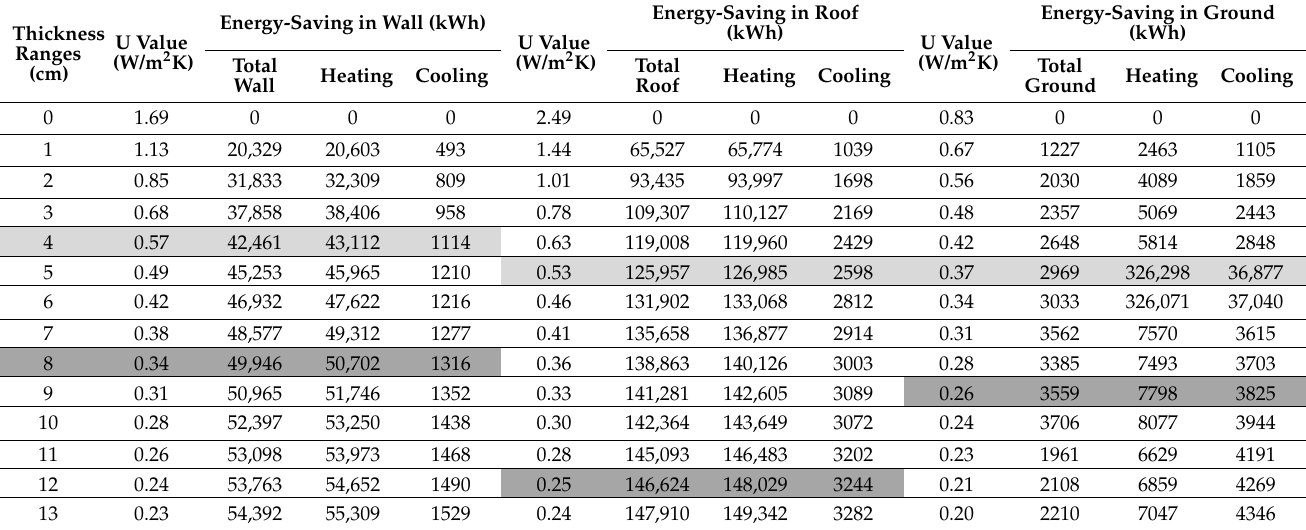
Table 7. Energy saving via thermal insulation material thicknesses in the building